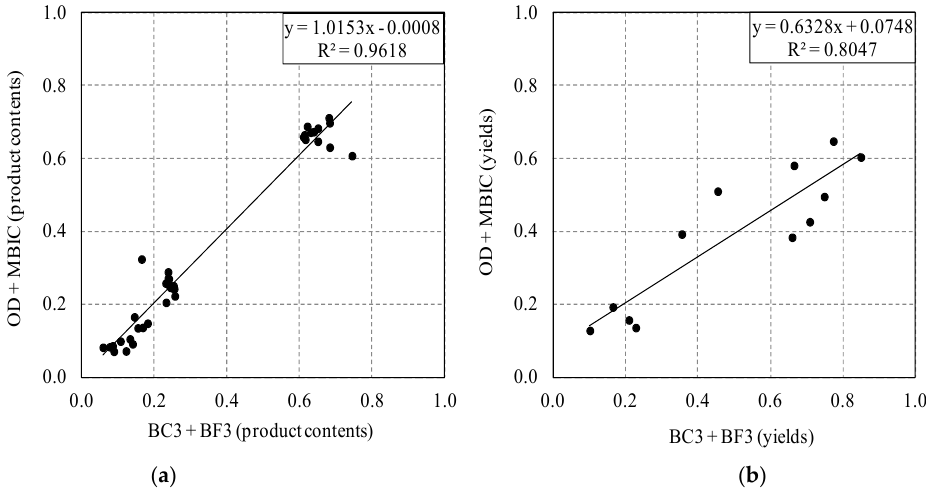
Figure 9. Correlation curves for product content ( a ) and yield ( b ) values considering the two reagent systems tested.